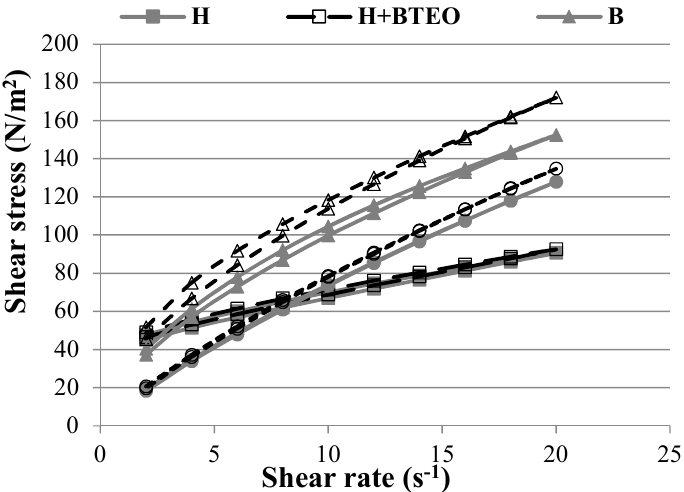
Figure 2. Rheograms of formulations without (H, B, O) and containing essential oil of Bidens tripartita (H + BTEO, B + BTEO, O + BTEO).